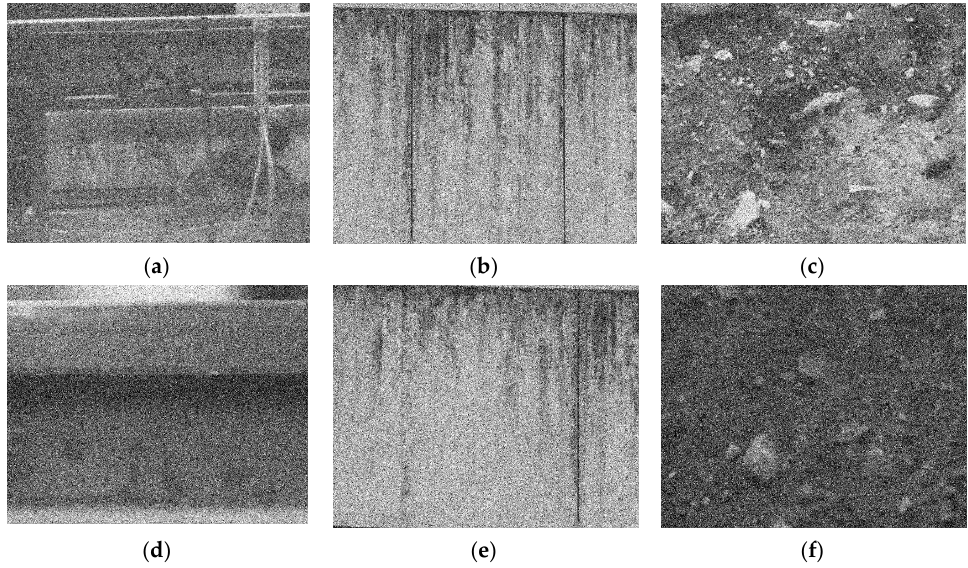
Figure 8. Simulation data, where ( a , d ) are iron texture, ( b , e ) are cement texture, and ( c , f ) are soil texture.